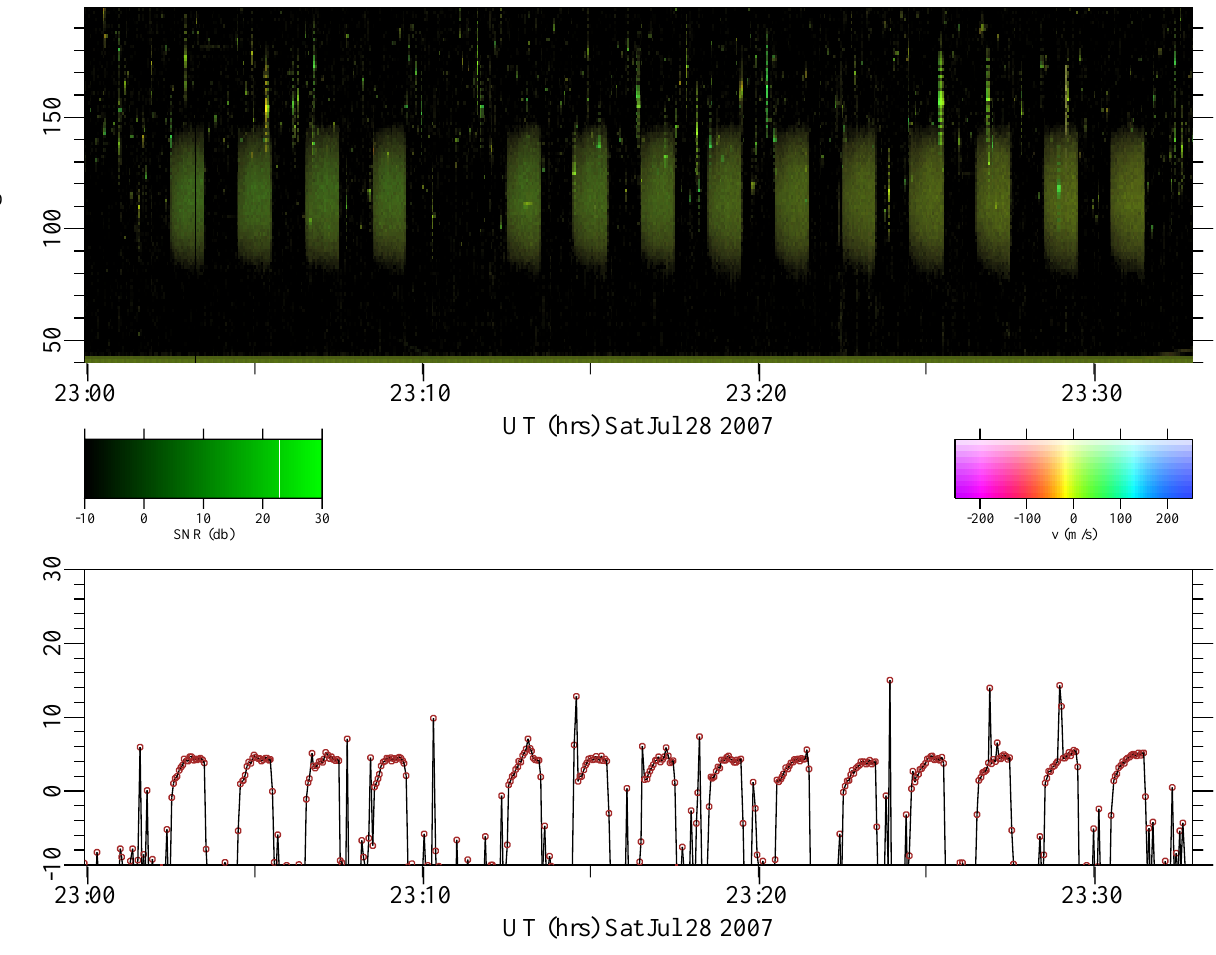
Fig. 6. RTDI plot for 28 July 2007. Note that ionospheric modification was interrupted during the gap around 23:18 UT. The lower panel shows the signal-to-noise ratio for echoes between 100–130 km.